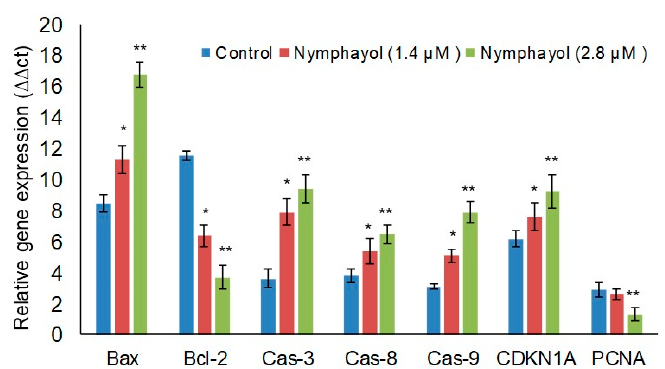
Figure 5. Effect of nymphayol on the expression levels of proapoptotic and tumor suppression related mRNA levels in MCF-7 cells after 48 h. Data are presented as the means ± SD (n = 6). Values sharing a common superscript as ** p ≤ 0.001 compared with 1.4 µM of nymphayol and vehicle control; * p ≤ 0.01 compared with the vehicle control.